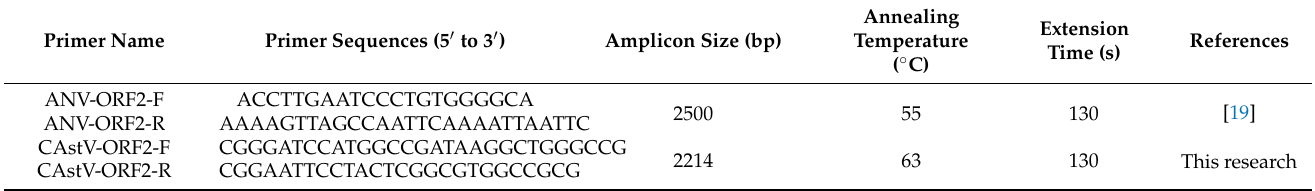
Table 3. RT-PCR amplification primers of complete open reading frame 2 (ORF2) gene of avian nephritis virus (ANV) and chicken astrovirus